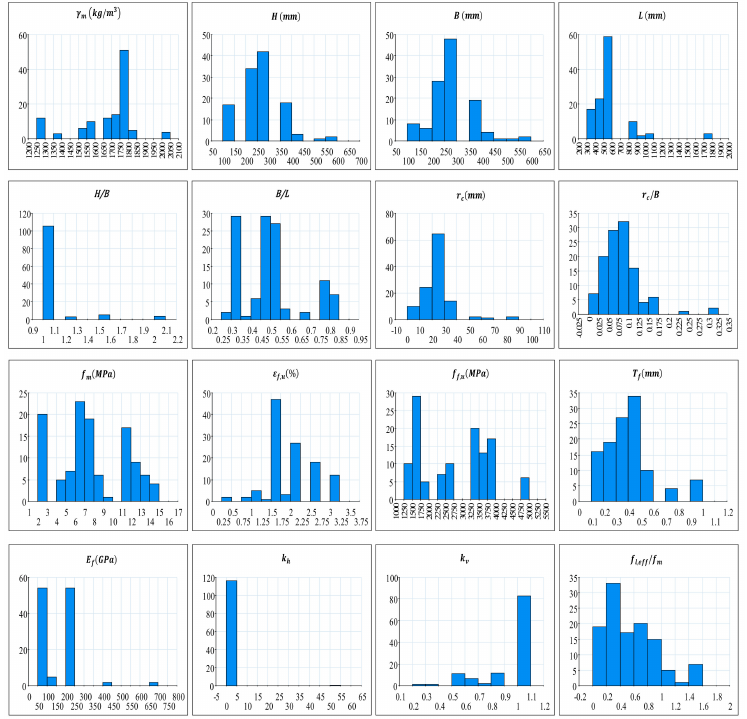
Figure 4. Distribution of the selected input